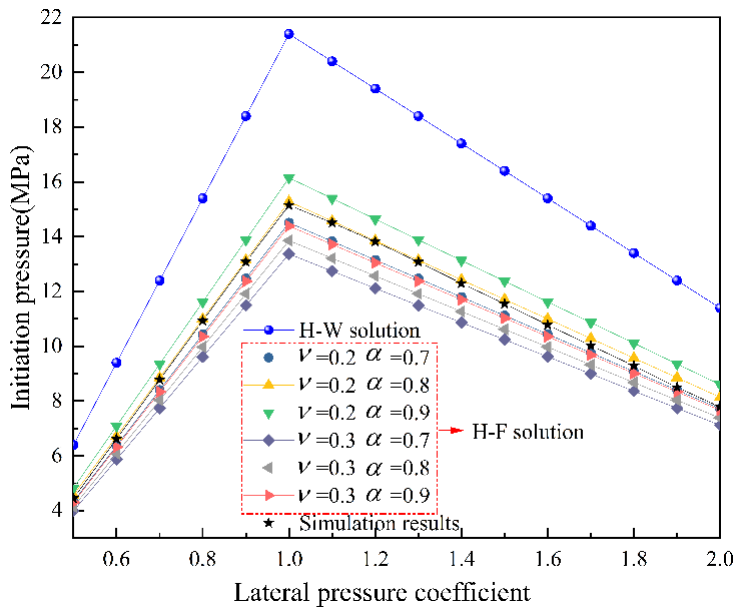
Figure 6. Comparison between numerical simulation and theoretical calculation results of crack in-